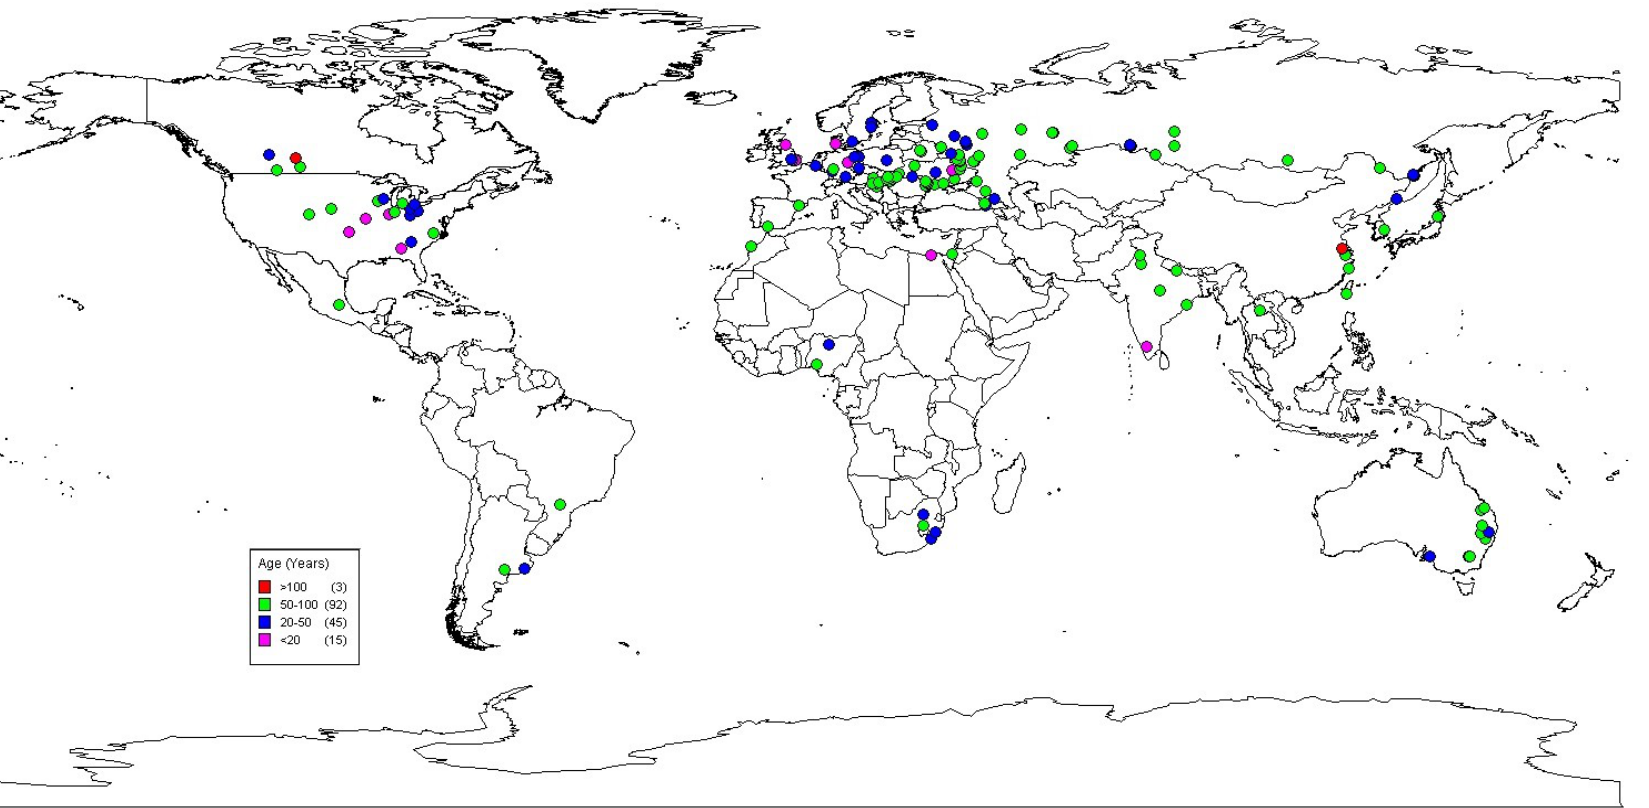
Figure 1. Global distribution of long-term experiments in arable ecosystems, categorised by duration: red established for >100 years; green, 50–100 years; blue, 20–49 years; pink, <20 years. Data sourced from the Duke University long term data archive ([50], Duke University, Durham, NC, USA), excluding non-arable sites and those with no location